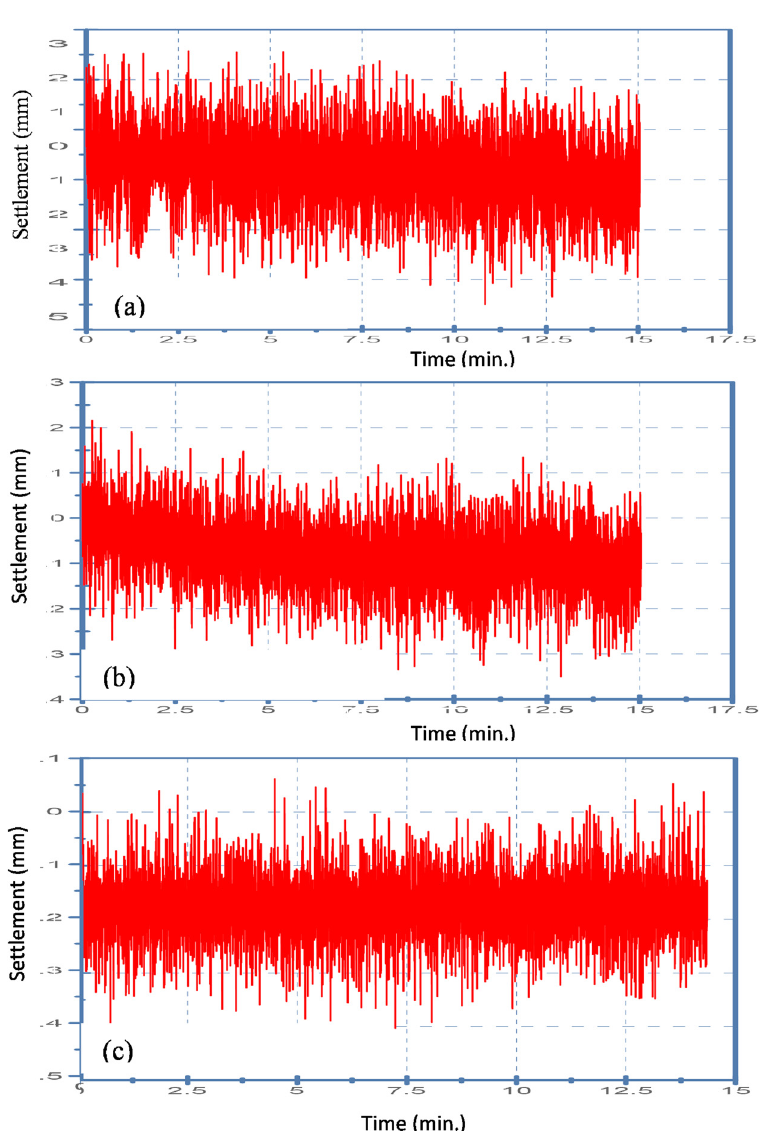
Figure 8: Variation in settlement with time under verticalvibration ( 10Hz ) . ( a ) No embedment, ( b ) embedment = 0.5H, and ( c ) embedment =